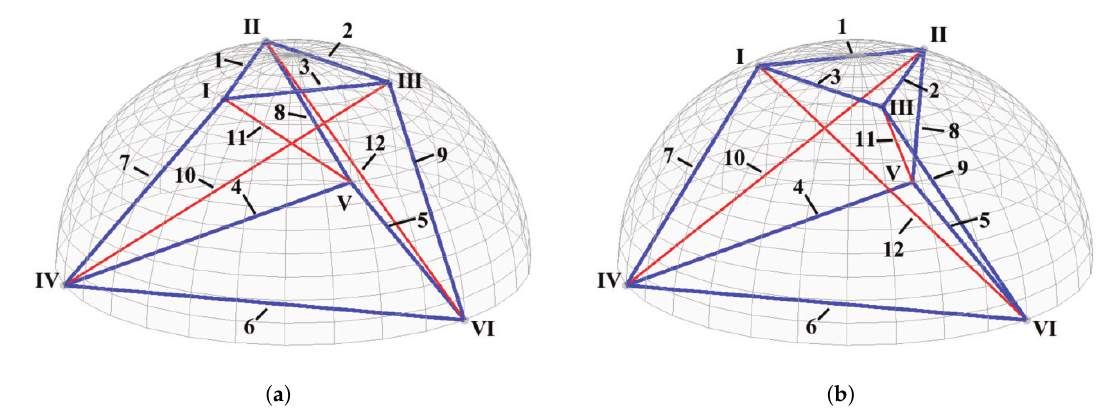
Figure 1. A rotationally symmetric prism-shaped tensegrity structure within a half-ellipsoid contour: ( a ) left-handed form ( b ) right-handed